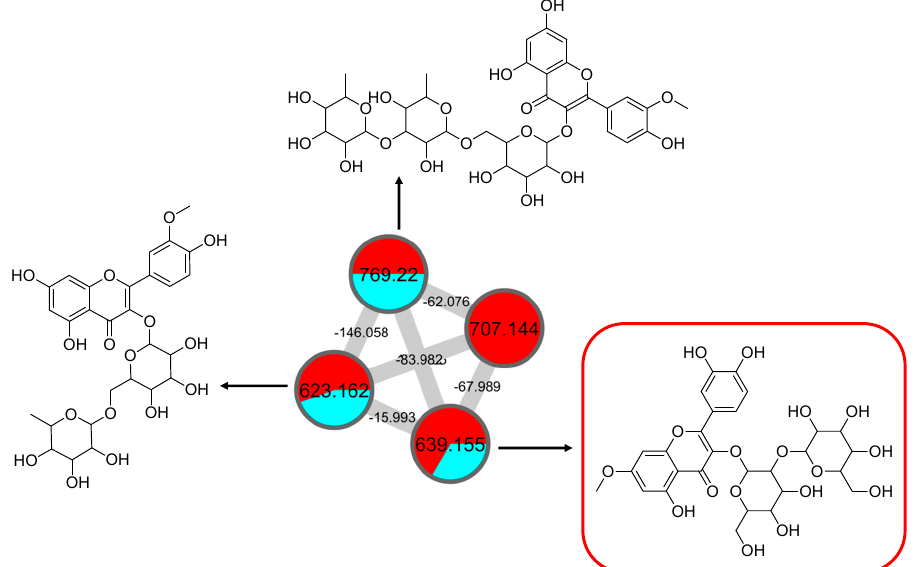
Figure 12. Mono-methoxyl flavonol 3- O -glycosides (cluster F in negative mode) from the full molecu- lar network (MN) of ethyl acetate fraction of flower C. ternatea (CTF_EA) extract. The metabolites in the red box were annotated based on GNPS library